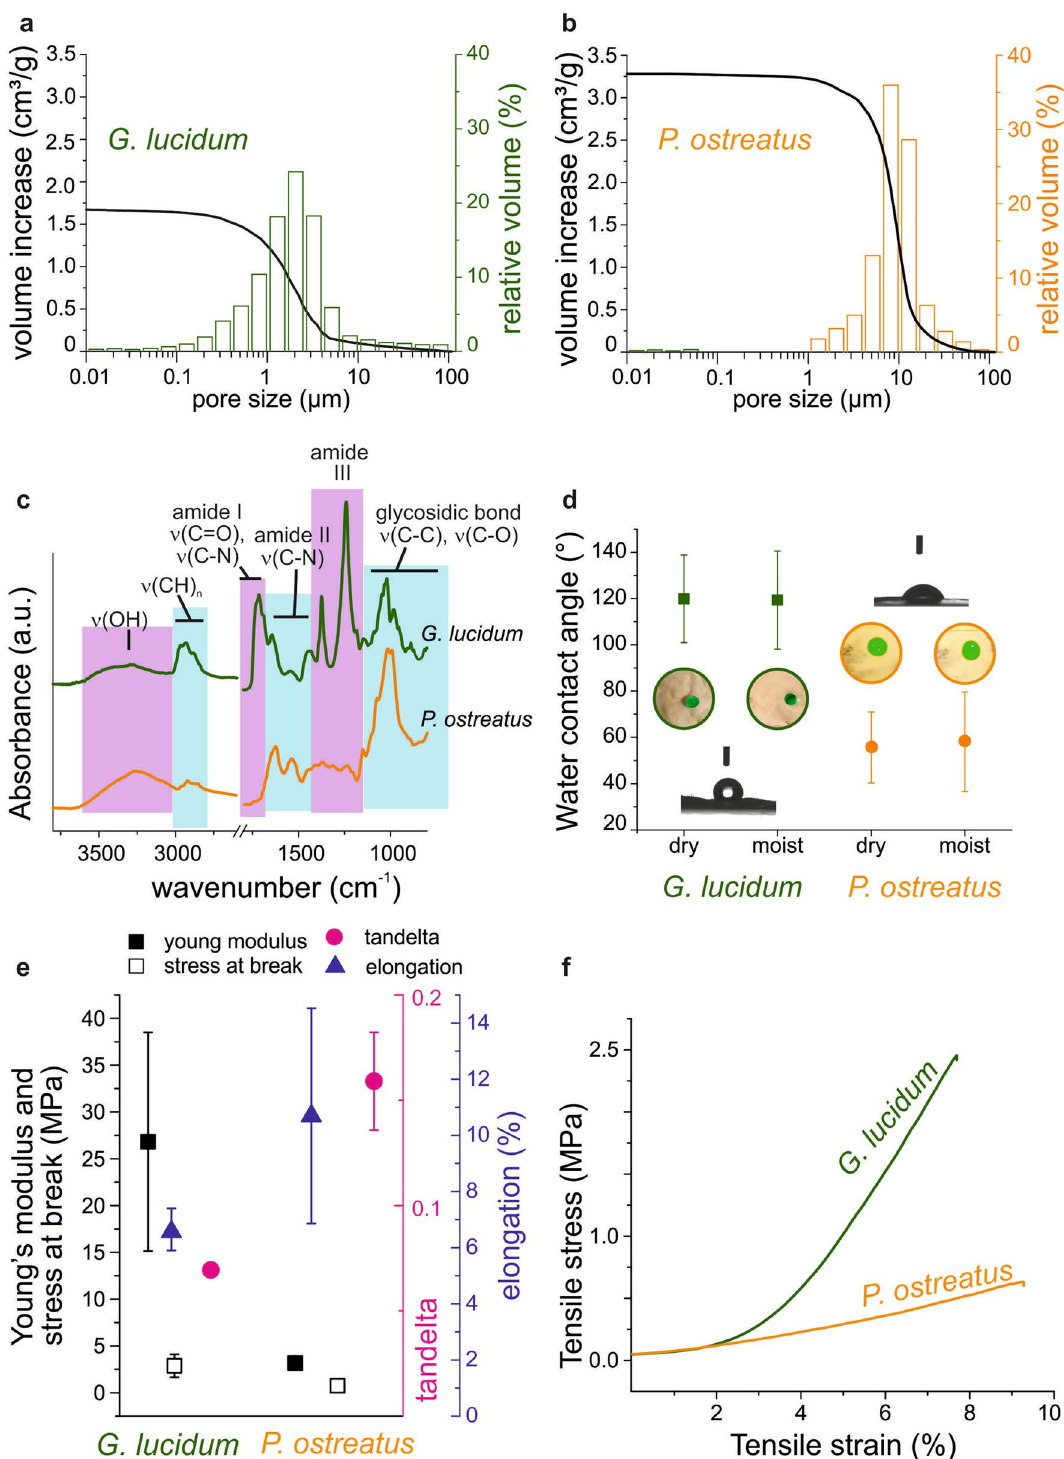
Figure 3. Porosity, chemical, hydrodynamical and mechanical features of mycelia. ( a , b ) Pore diameter distribution (bars) and total porosity (curves) measured by MIP; ( c ) ATR-FTIR spectra of the two mycelia; ( d ) Contact angle of dry and moist mycelia. Inset: colored water drops on mycelium pieces of both strains, either dry or moist. The drops volume is 5 μL. ( e ) Young modulus, stress at break and elongation results after the tensile test; tanδ values after DMA analysis. ( f ) Tensile test curves of the two mycelia under